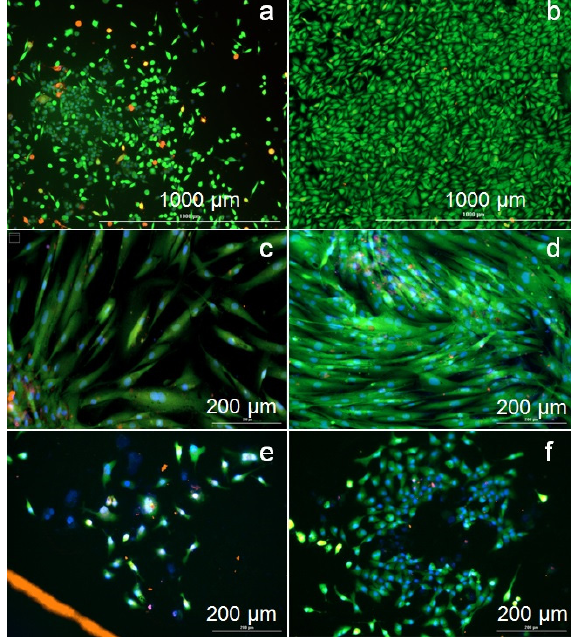
Figure 8. MMSCs cultivated in a medium containing the extracts of WE43 Hom. ( a , c ) and WE43 MAD ( b , d ) at different magnifications: ×100 ( a , b ) and ×200 ( c , d ), and on the surface of alloy samples based on WE43 Hom. ( e ) and WE43 MAD ( f ). Cell staining with the Live/Dead Double Staining reagent kit (Sigma, Ronkonkoma, NY, USA): live cells—green color, dead cells—red color. Cell nu- clei were stained with Hoechst—blue